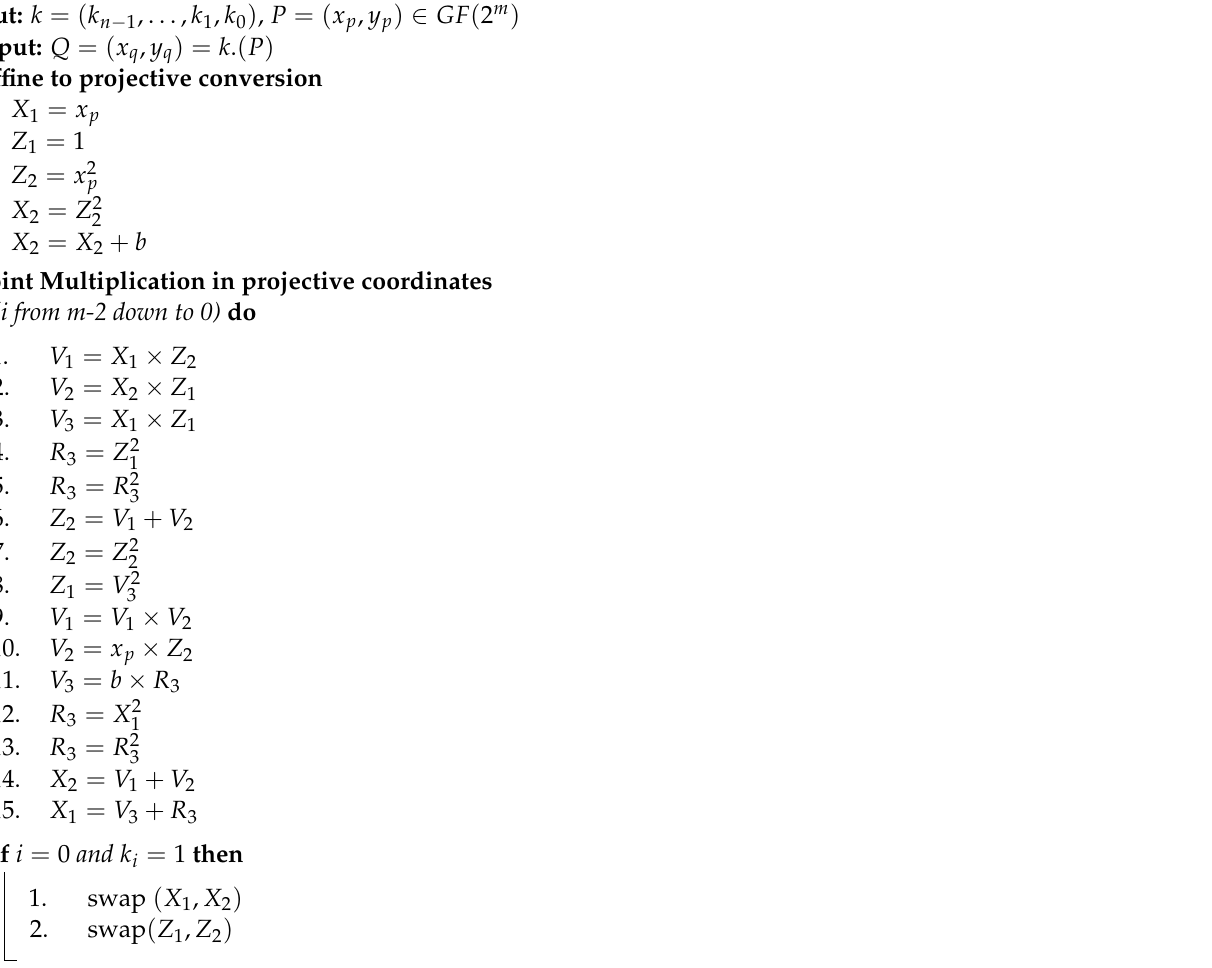
Algorithm 1: Lopez–Dahab PM Algorithm